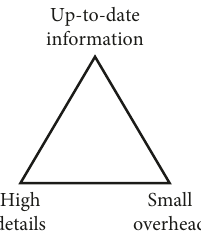
Figure 6: DTN management trilemma: only two out of three desired properties of the management messaging can be achieved simultaneously. Figure